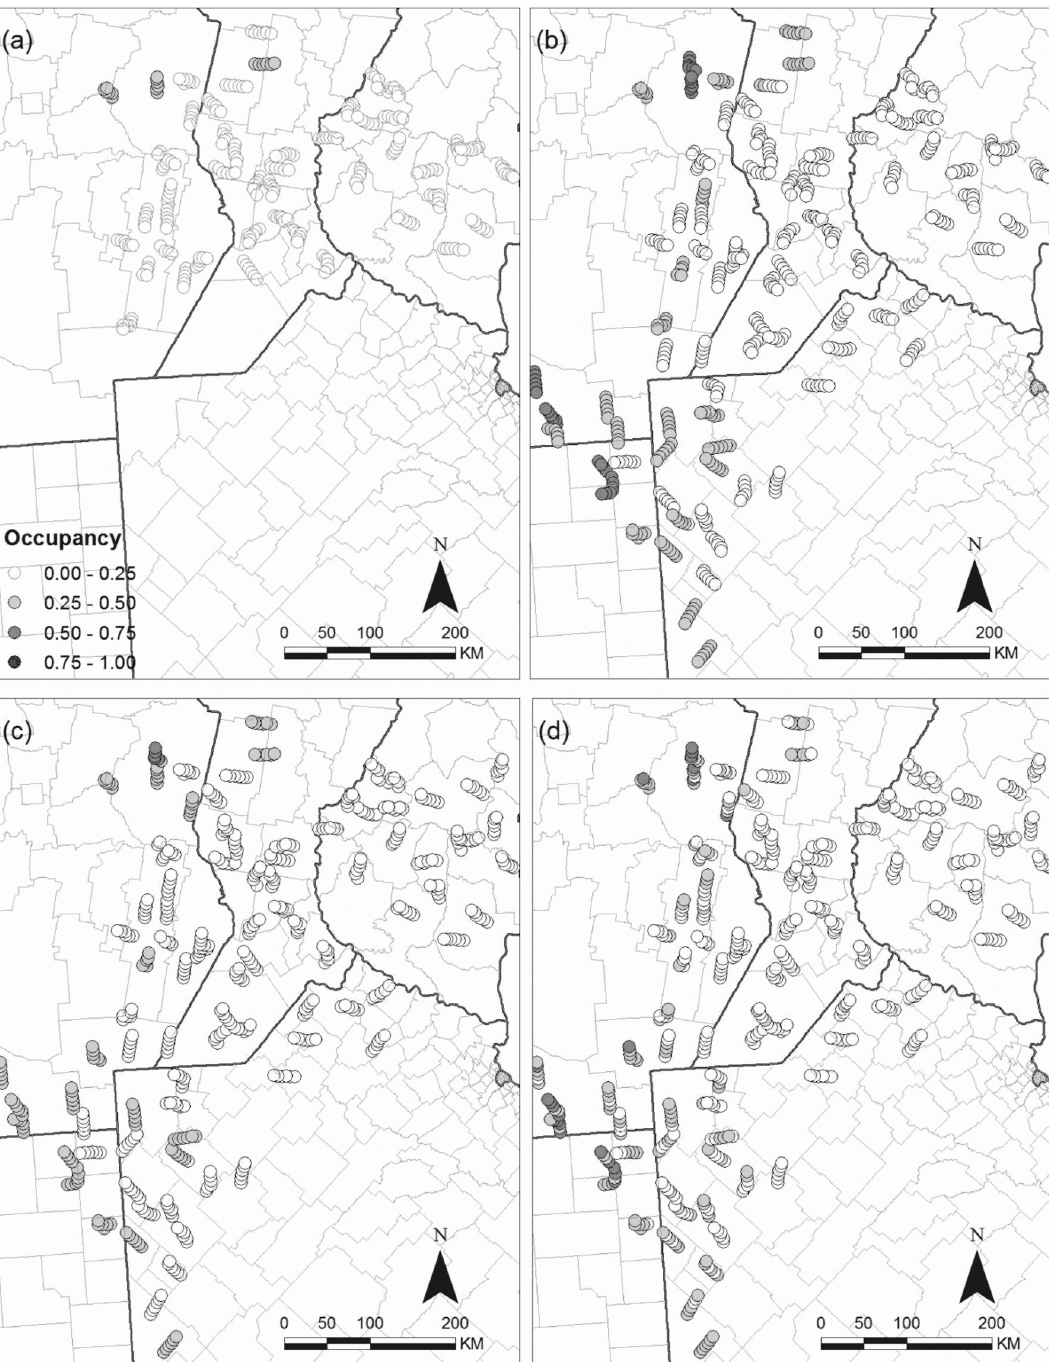
Fig 9. Vermilion Flycatcher Pyrocephalus rubinus occupancy ( ^ ψ ) in the regional bird monitoring area in Argentina. Occupancy of the species is represented for (a) 2003, (b) 2006, (c) 2009, (d) 2012.